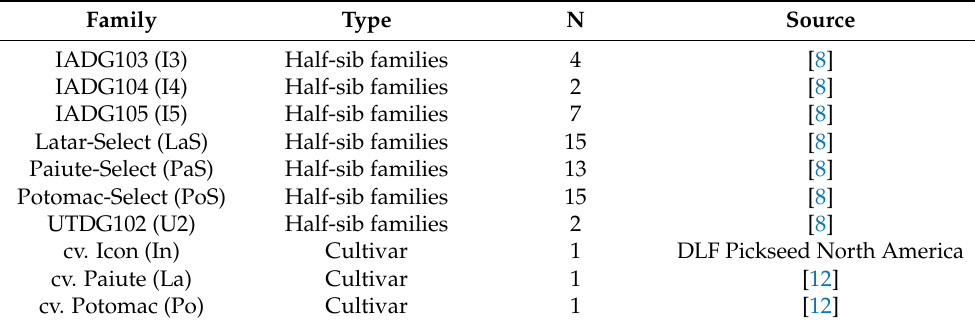
Table 1. Dactylis glomerata half-sib family source populations, including the number (N) of families corresponding to each population; and